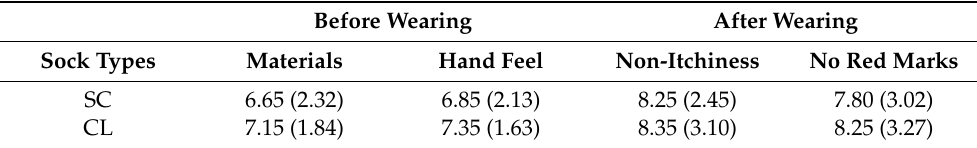
Table 1. Means scores of sensory/tactile comforts based on sock types.